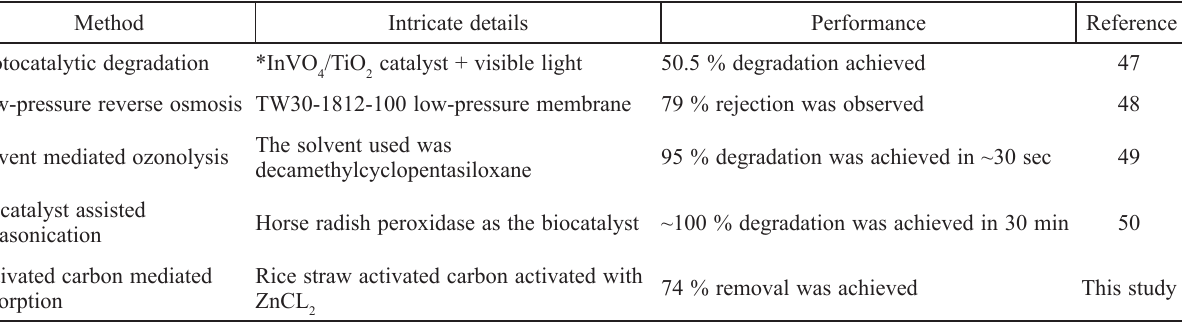
Table 6 – Comparative study with other methods